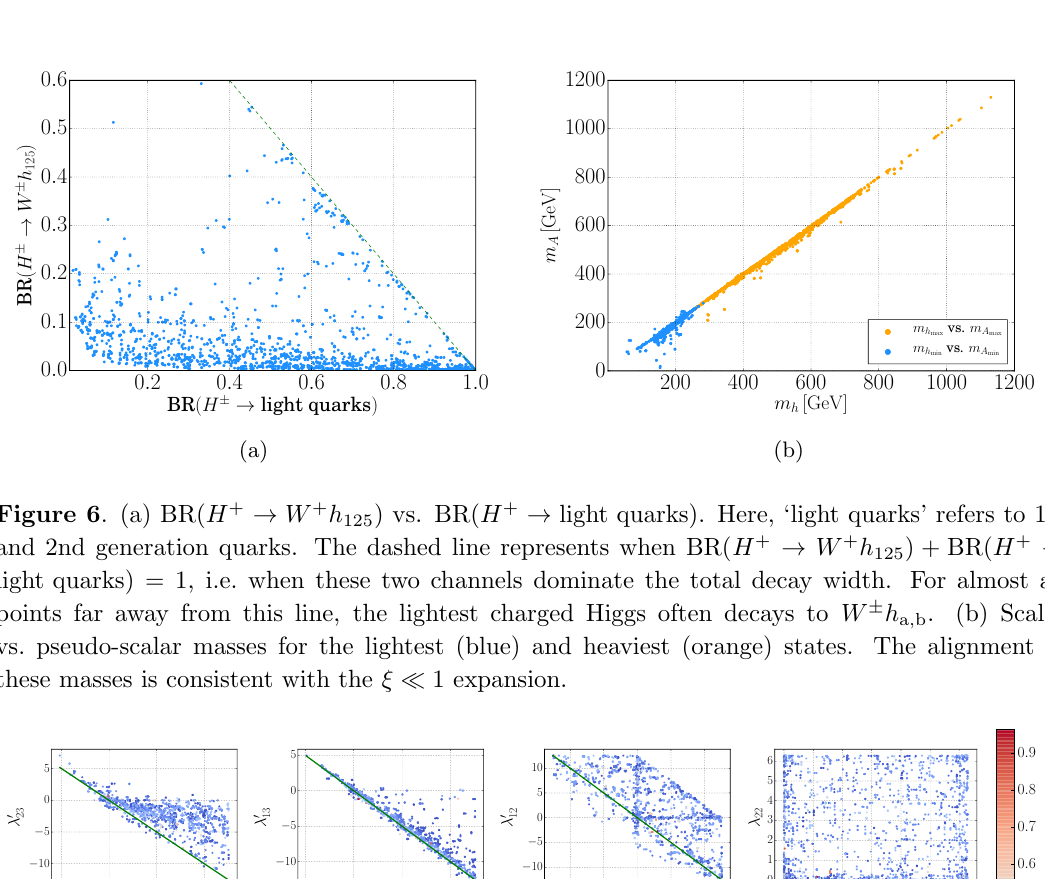
(cid:21) 0 ij (cid:0)